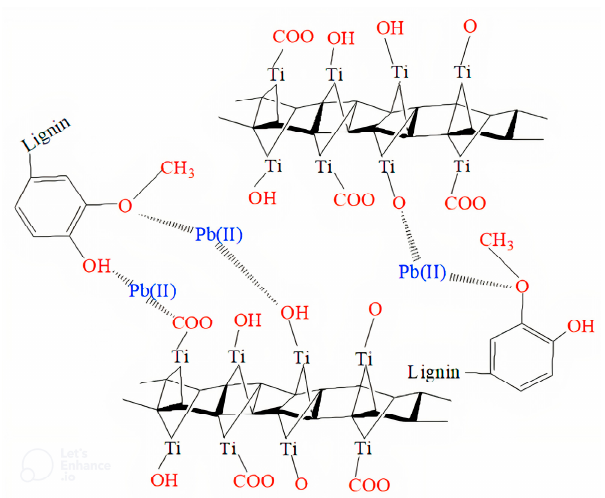
Figure 5. Removal mechanism of Pb(II) ions with Ti 2 CT X -EHL